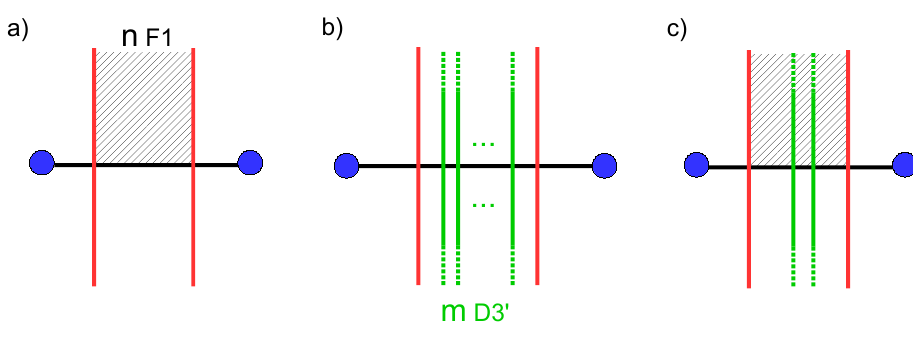
Figure 31 . Products of HB operators (mesons) are inserted by adding several F1 strings and D3’ branes to the setups. a) n semi F1s inserting ( Z 2 1 ) n , b) m D3’s inserting Y m = ( Z 2 2 (cid:0) (cid:24) 2 ) m , c) One semi F1 and two D3’s inserting Z 2 1 Y 2